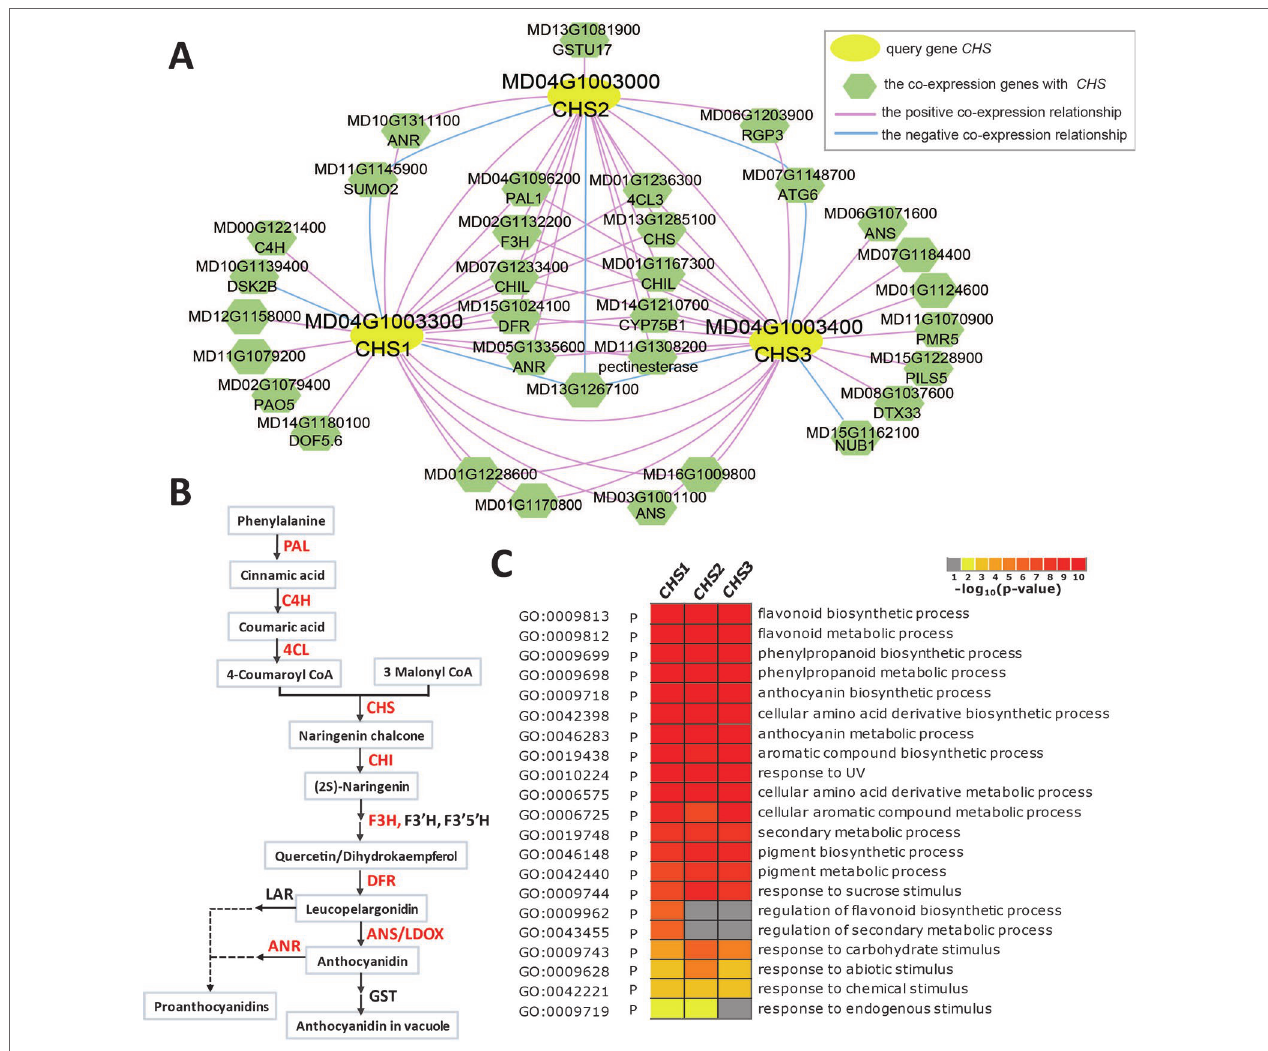
FIGURE 3 | Global co-expression network analysis of MdCHS , related to anthocyanin biosynthesis. (A) The global co-expression network of MdCHS1 (MD04G1003300), MdCHS2 (MD04G1003000), and MdCHS3 (MD04G1003400). The yellow circles are the three MdCHS genes, and the green polygons are genes co-expressed with MdCHS . The red line indicates positive co-expression with MdCHS, and the blue line indicates negative co-expression with MdCHS . (B) Anthocyanin biosynthesis pathway. The genes marked in red are in the global co-expression network of MdCHS . (C) GO enrichment analysis of all genes in the global co-expression network for MdCHS1 , MdCHS2 , and MdCHS3 by agriGOv2